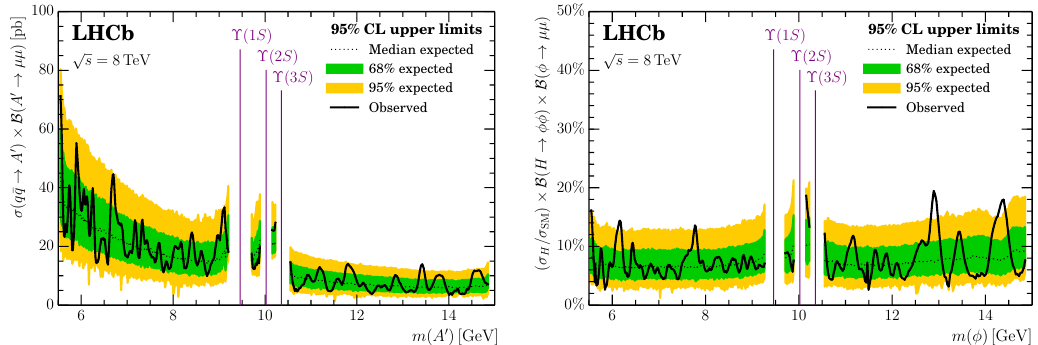
Figure 5 . (Left) Upper limits on the production of vector A 0 bosons produced in 8 TeV pp -collisions through Drell-Yan and decaying to (cid:22) + (cid:22) (cid:0) . (Right) Upper limits on the branching fraction of a